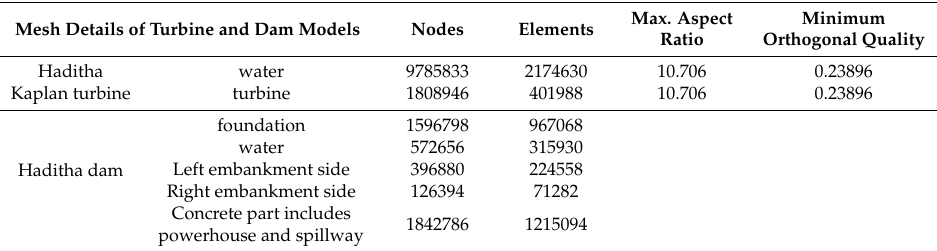
Figure 4. The concrete part of Haditha dam includes the spillway and powerhouse, and the 3-D FE model of the Haditha dam, includes the turbine units. Table 3. The mesh details of the Haditha Kaplan turbine and dam models.